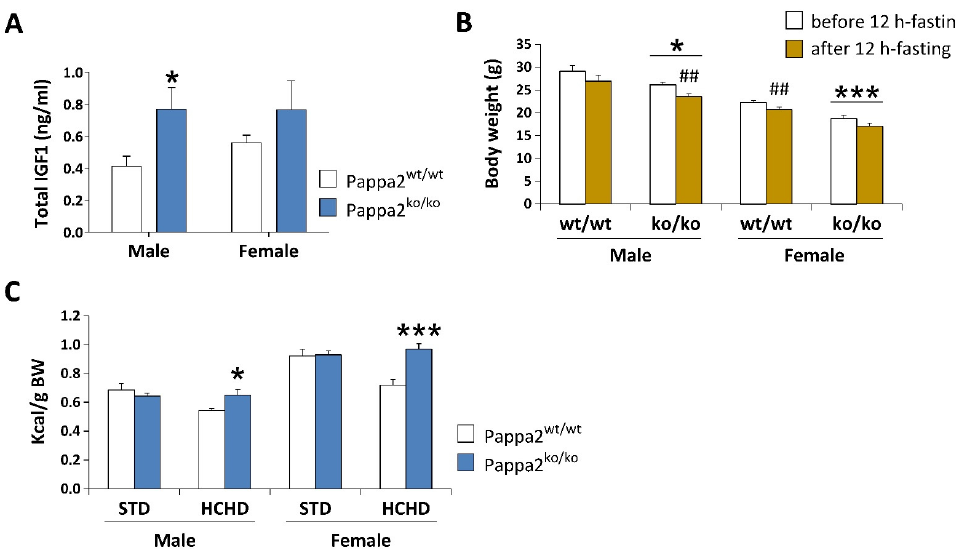
Figure 5. Analysis of plasma concentrations of total IGF1 ( A ), body weight (BW) before and after 12 h-fasting ( B ), and caloric intake relative to BW after 3 week-feeding of a standard (STD: 2.9 kcal/g) or a high carbohydrate (HCHD: 3.85 kcal/g) diet ( C ) in constitutive Pappa2 KO mice of both sexes at 8 months old. Data are represented as mean ± S.E.M. ( n = 7–8/group). Tukey-corrected tests: * / *** p < 0.05/0.001 versus respective Pappa2 wt/wt mice; ## p < 0.01 versus mice before 12